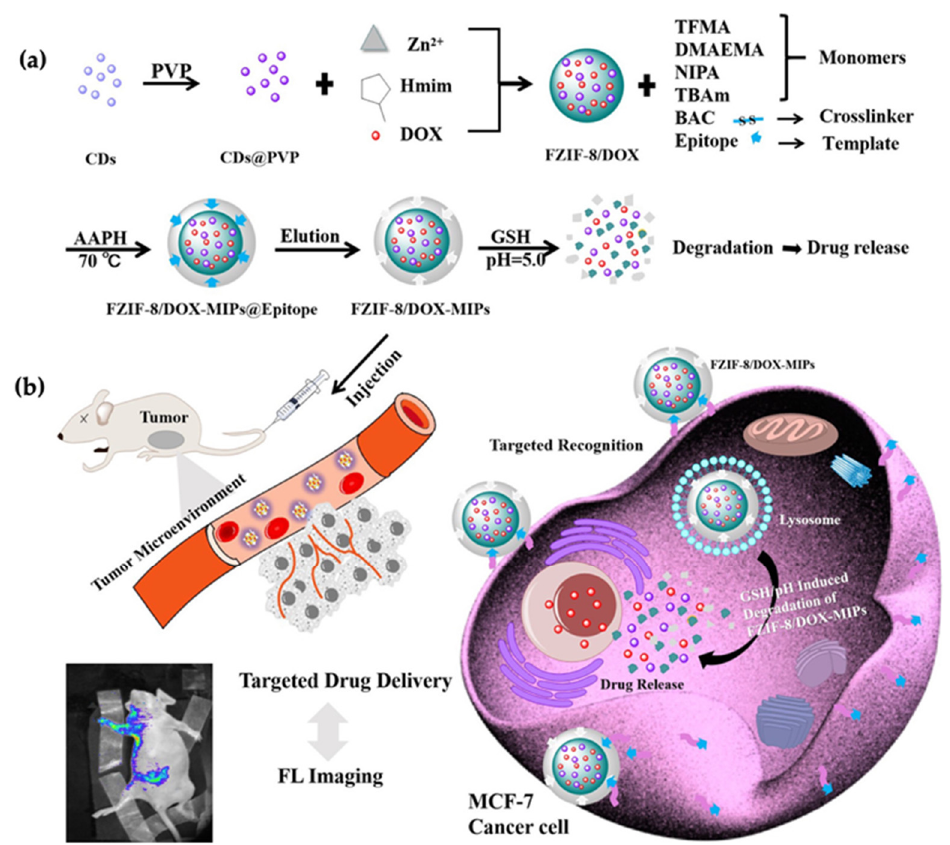
Figure 12. ( a ) Synthesis of tumor-sensitive degradable DOX-loaded MIP nanoparticles, ( b ) illustration of targeted imaging and drug delivery. Reproduced with permission from [94].